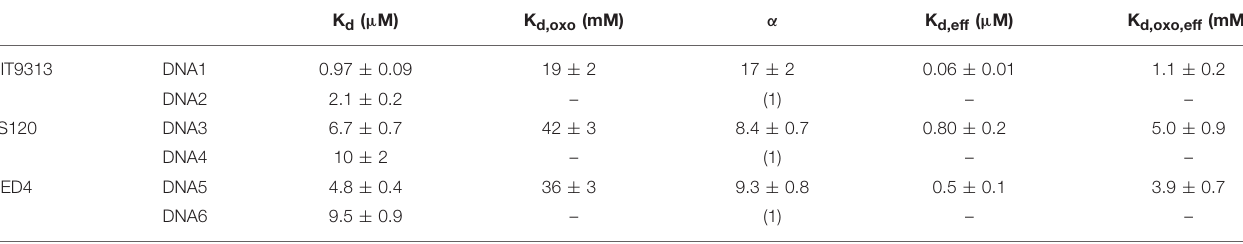
TABLE 2 | Isothermal titration calorimetry parameters of the NtcA— glnA promoter interaction in Prochlorococcus MIT9313, SS120, and MED4.